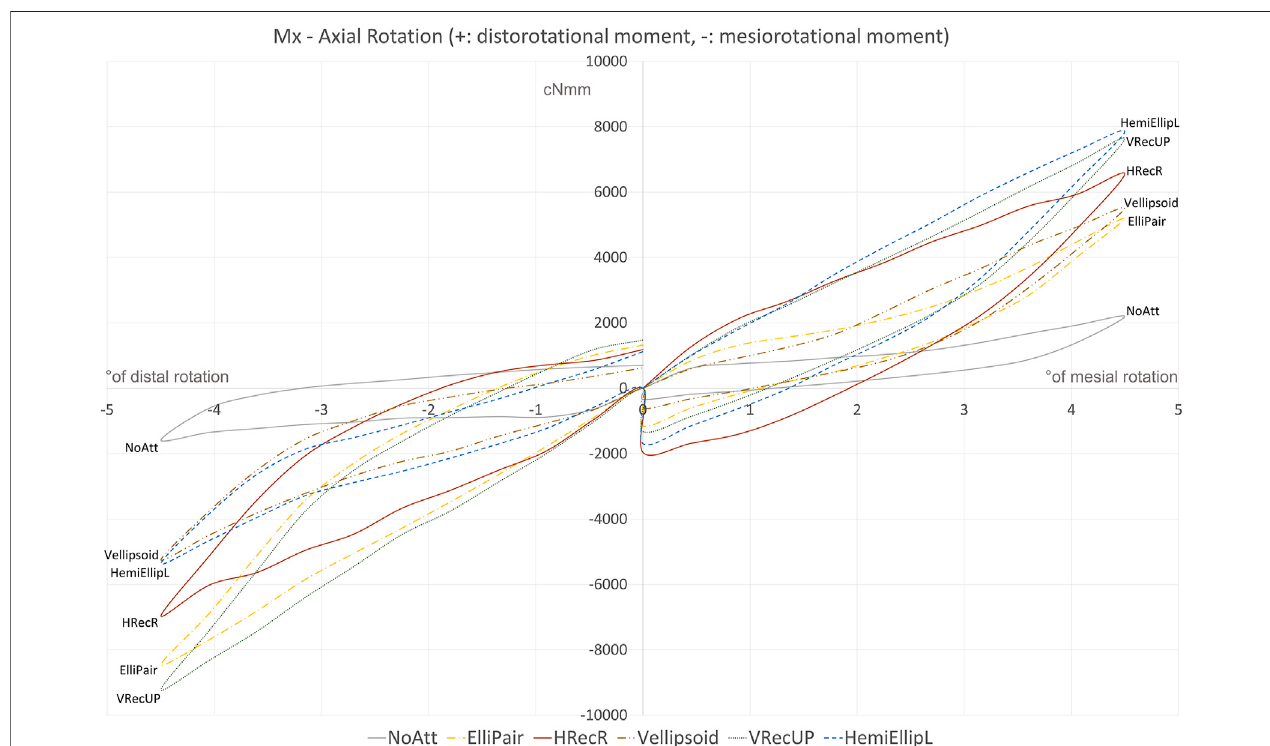
FIGURE5 | Best performing attachmentfrom each ofthe fi ve groups and the “ NoAtt ” setup.Vertical Rectangular attachments performed best on both mesial and distal rotations. HemiEllipL performed best on disto-rotation but not on mesio-rotation. Worth noticing the high moments created after only 1 ° of rotation and also the small degree of permanent deformation and fatigue in the aligner when looking at the de-activation part of the hysteresis loop. The time needed to reach 4.5 ° rotation either side (0 ° – 4.5 ° ) was 64 ° s, time that clinically translates to an instance when snapping the aligner in place.